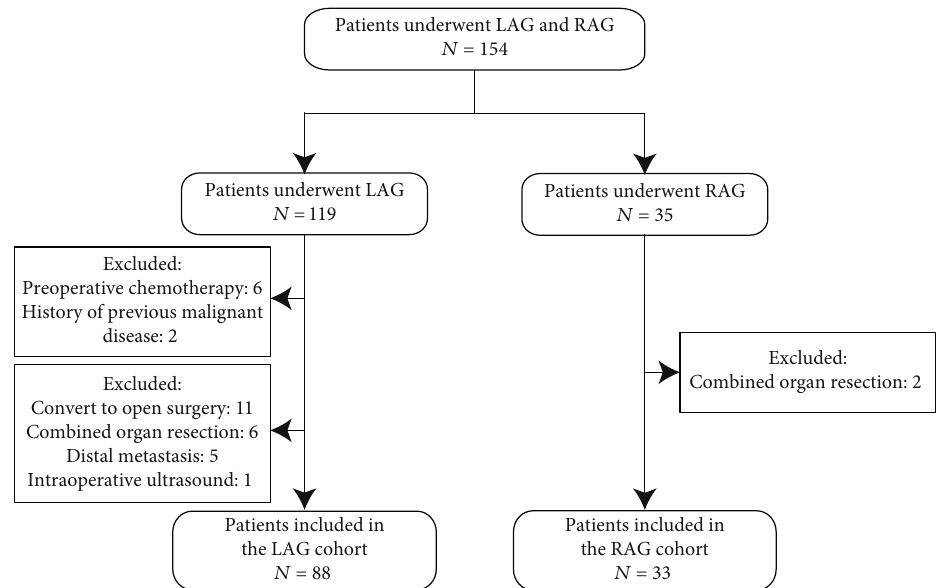
Figure 1: Flow chart of this